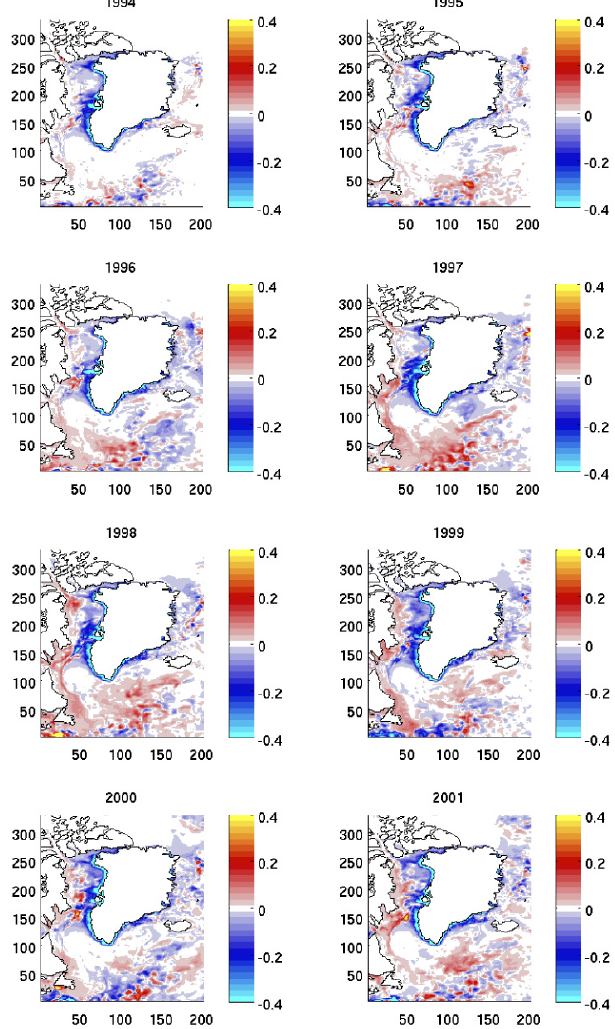
Fig. 8. Annual mean surface salinity anomalies (psu) for the period